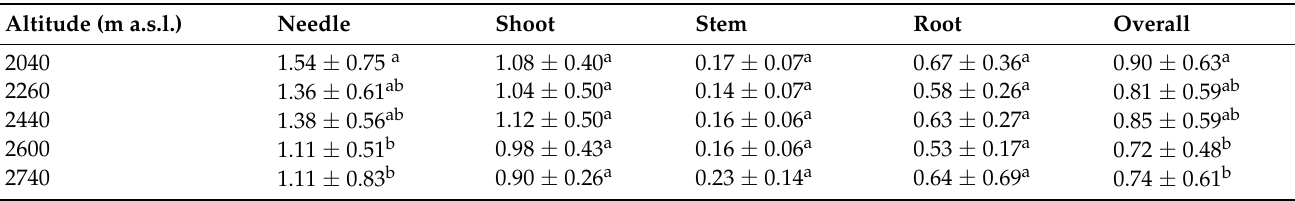
Figure 2. Comparison of the concentrations of soluble sugars (SS, % dm), starch (% dm), and NSC (% dm) in the needles, shoots, stems, and roots of L. principis-rupprechtii among the different sites (mean ± SD). Different lowercase letters indicate significant differences among NSC at the 0.05 level. Table 2. Comparison of the soluble sugar–starch ratio (SSR) in the needles, shoots, stems, and roots of L. principis-rupprechtii among the different sites (mean ± SD). Different lowercase letters indicate significant differences at the 0.05